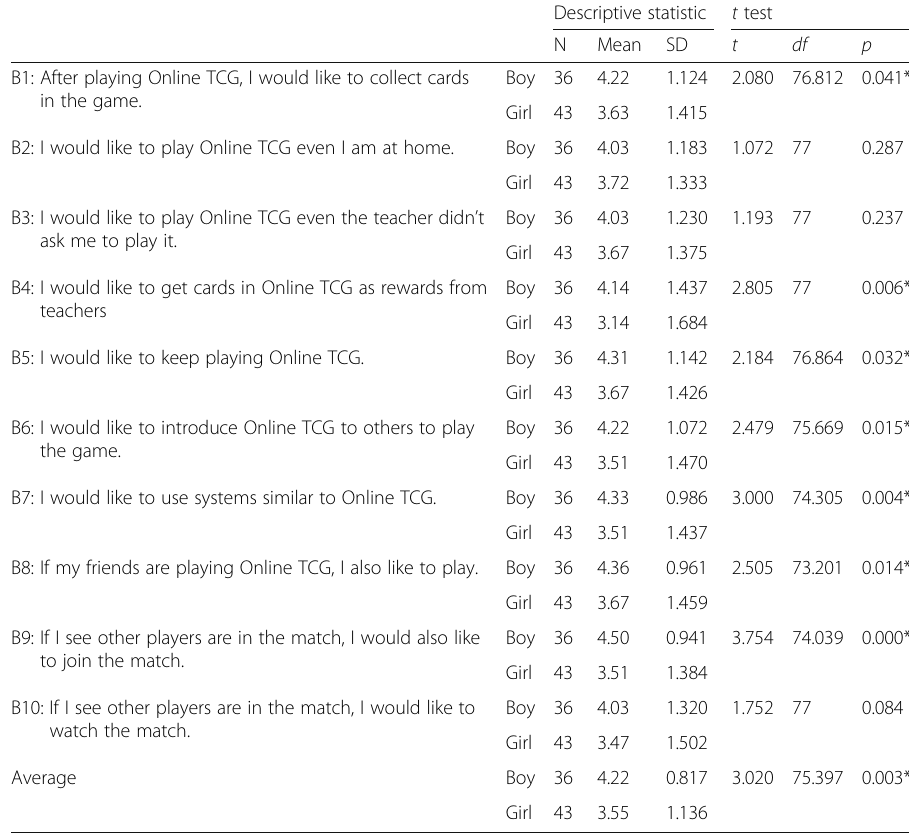
Table 8 Independent t test result for students ’ Behavioral Intention score (gender difference analysis)